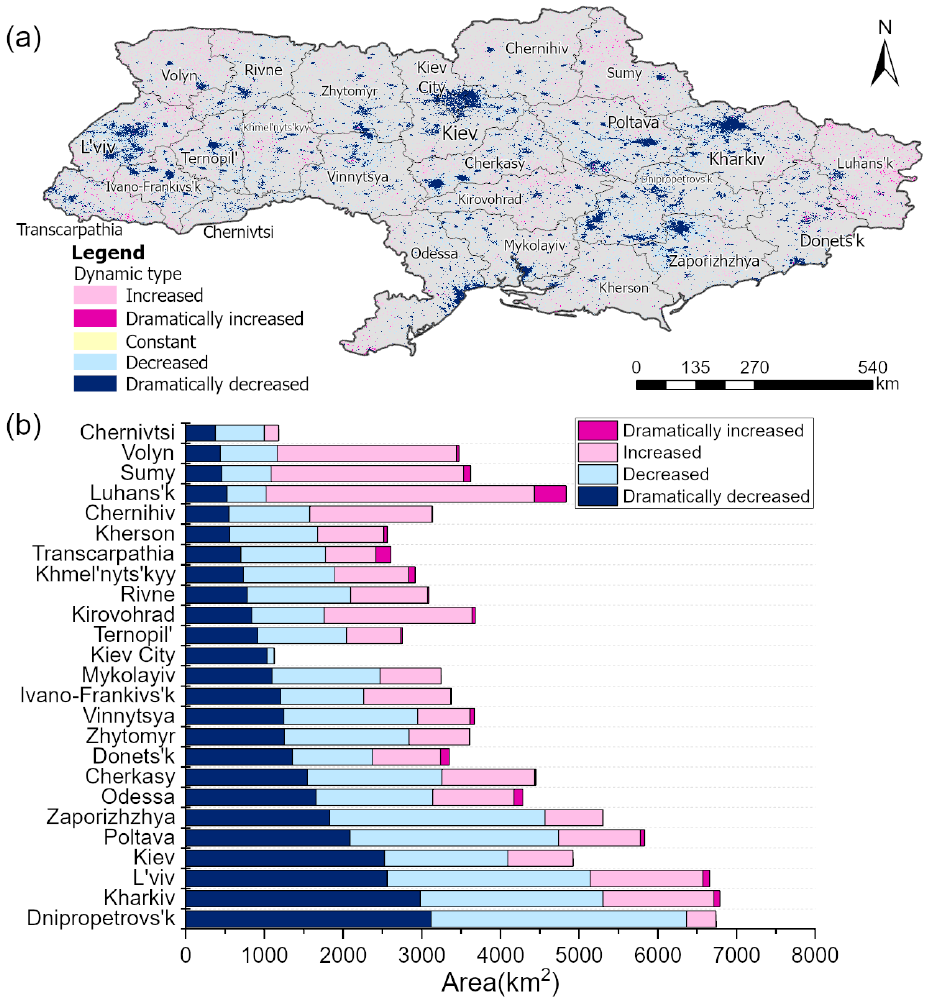
Figure 5. ( a ) Spatial distribution of the identified radiation dynamic types and ( b ) area composition for the period 15 February 2022–15 March